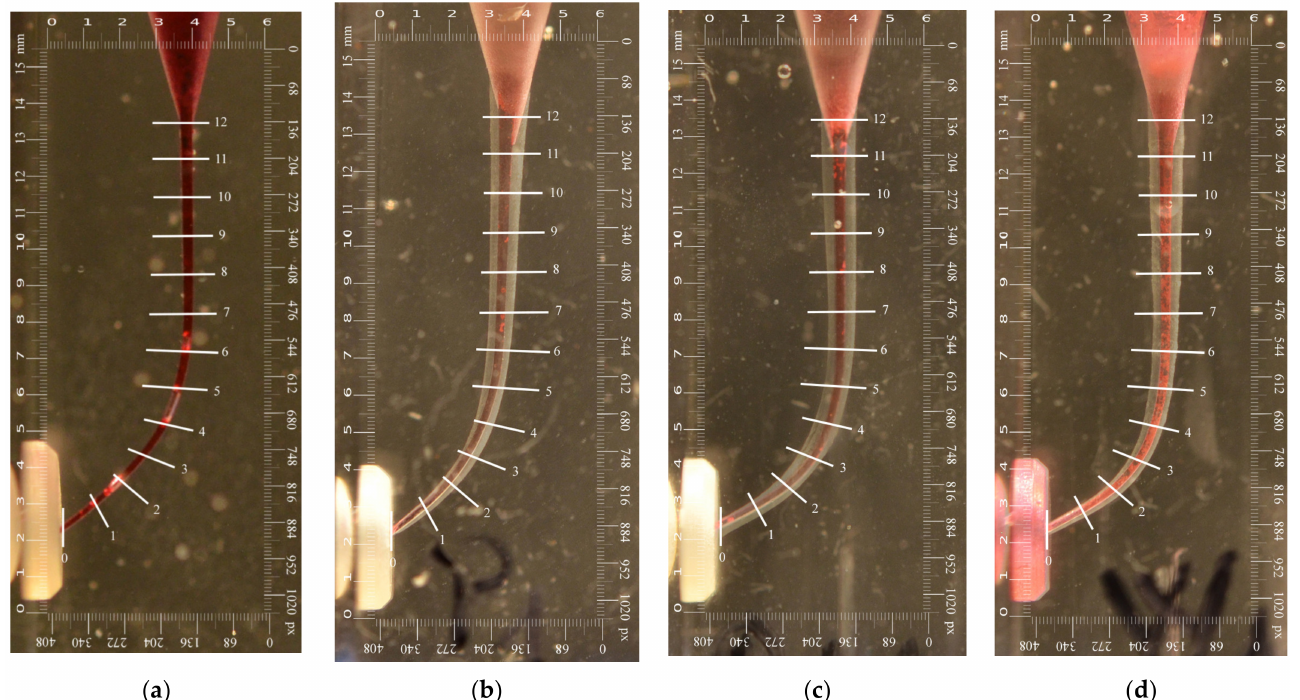
Figure 2. Images of the simulated root canals before/after shaping (examples). ( a ) Initial contour of one of the root canals before shaping. Root canal after shaping with ( b ) PTG (Group 1); ( c ) RB (Group 2); ( d ) WOG (Group